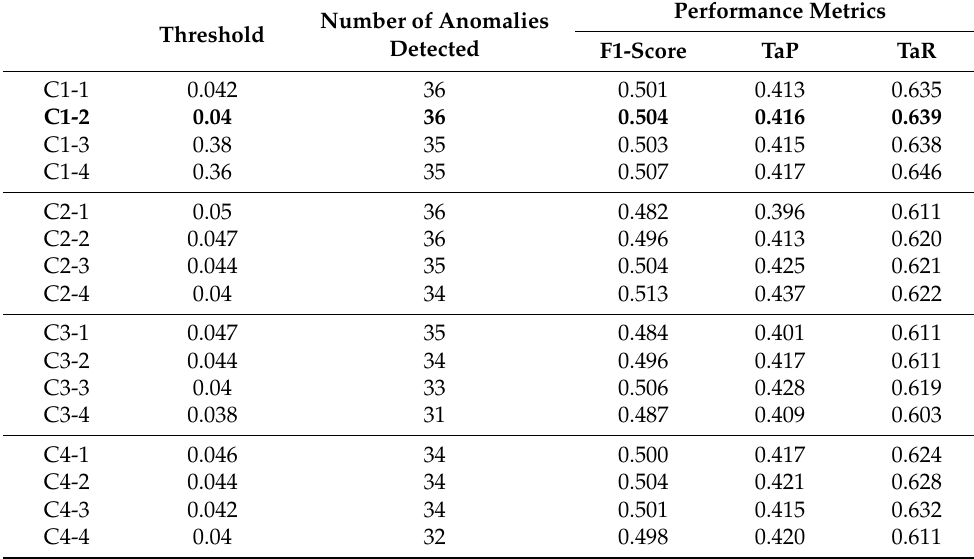
Table 9. Performance metrics according to the threshold of each case.